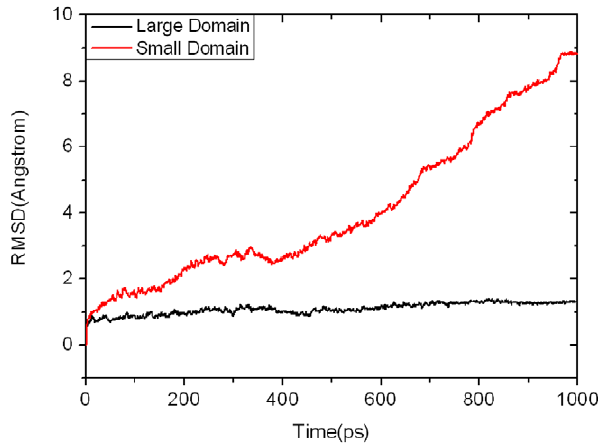
Figure 5. Time dependency of wRMSDs of the large domain (black line) and small domain (red line) in GK during the TMD simulation.